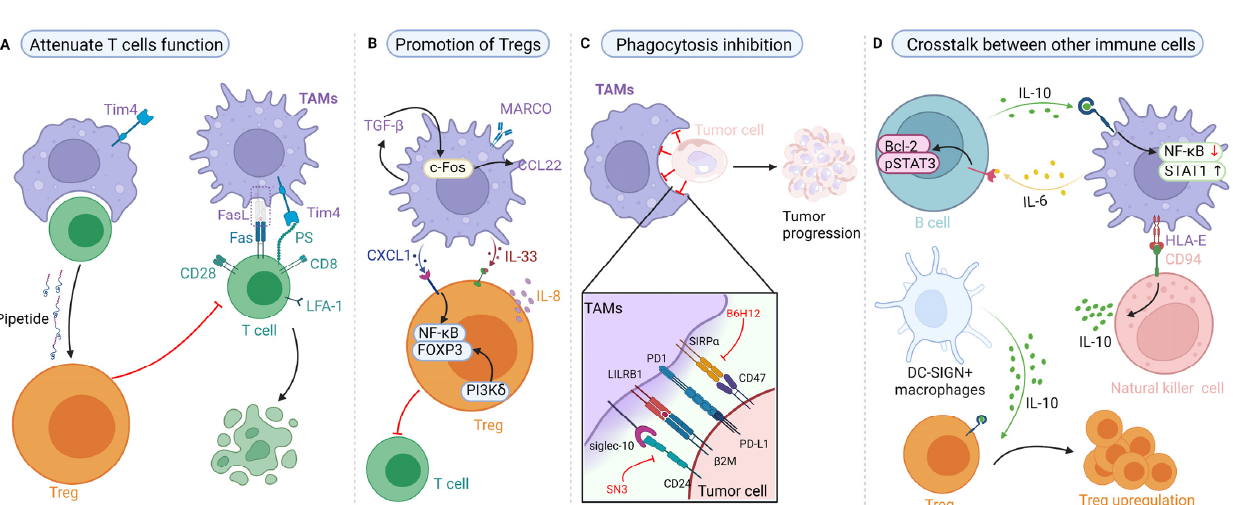
cytosis of TAMs. Applying SN3 and B6H12 to block SIRP α /CD47 axis and siglec-10/CD24 axis, re- spectively, could reverse the inhibition of phagocytosis. ( D ) TAM crosstalk with other immune cells, such as B cells and natural killer cells, via the release of IL-6, IL-10, and the binding between HLA- 3 and CD94. Even the DC-SIGN+ macrophages could express a high level of IL-10 to upregulate Tregs. BCL2: B-cell lymphoma 2; LFA-1: lymphocyte function-associated antigen-1; MARCO: mac- rophage receptor with collagenous structure; c-Fos: a proto-oncogene regulating the transcription of many